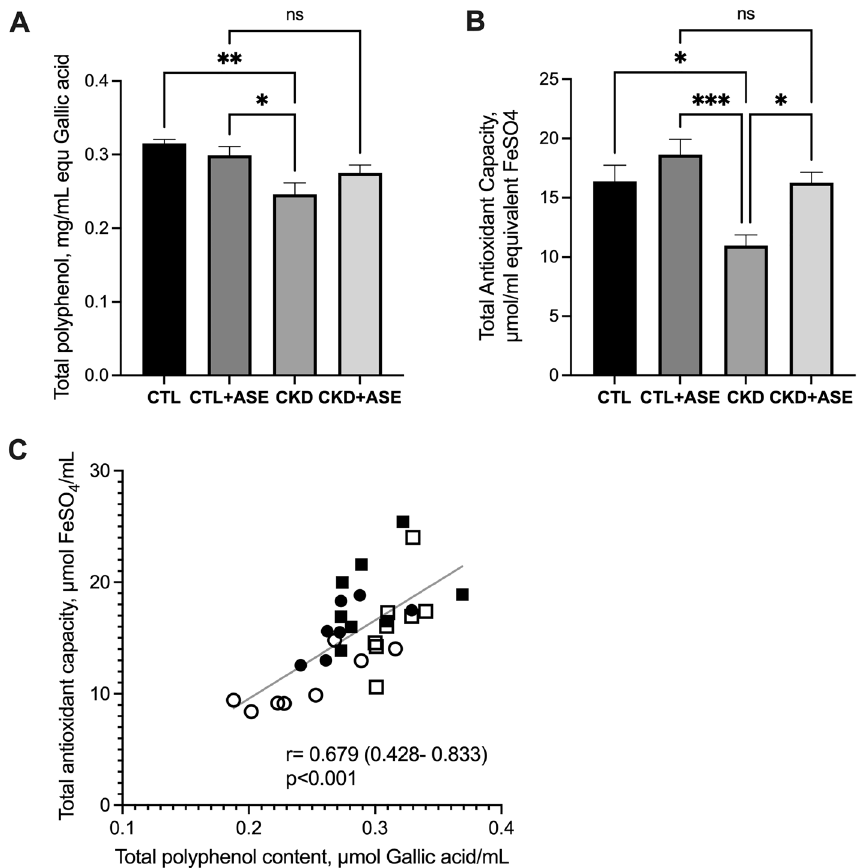
Figure 8. Total polyphenol content and total antioxidant capacity of plasma. ( A ) Plasma total polyphenol content was assayed according to the method of Folin–Ciocalteu using gallic acid as standard. The results were expressed as µmol equivalents of gallic acid per mL. ( B ) Plasma total antioxidant capacity evaluated by the ferric reducing ability of plasma (FRAP) assay. The results were expressed as µmol equivalents of FeSO 4 per mL. ( C ) Relationship between plasma polyphenol content and its antioxidant capacity for control mice (open squares), control + ASE (solid squares), CKD (open circles) and CKD + ASE (solid circles) mice. Data are expressed as mean ± SD for n = 8 animals in each group. Significant differences were determined by two-way ANOVA followed by Tukey’s multiple comparison test. Different letters indicate a significant difference between groups at the P < 0.05